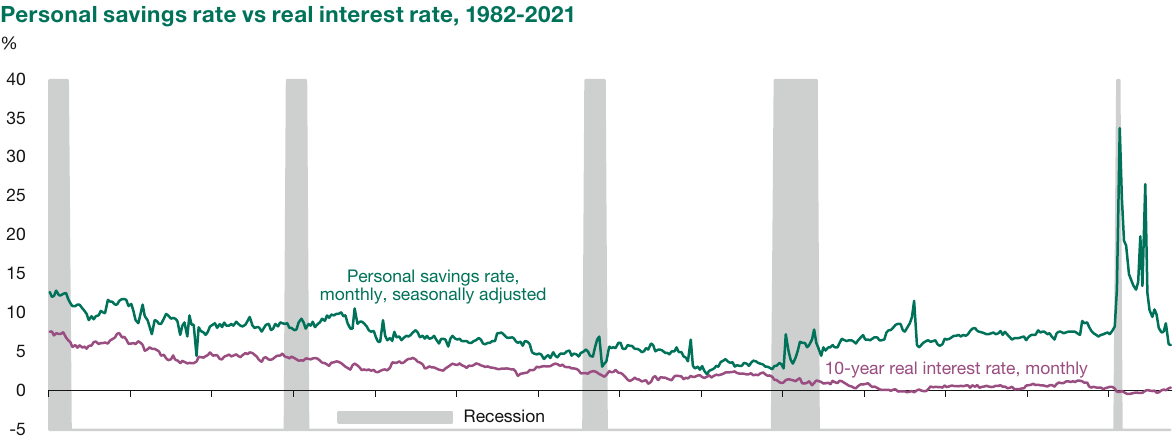
Personal savings rate vs real interest rate,